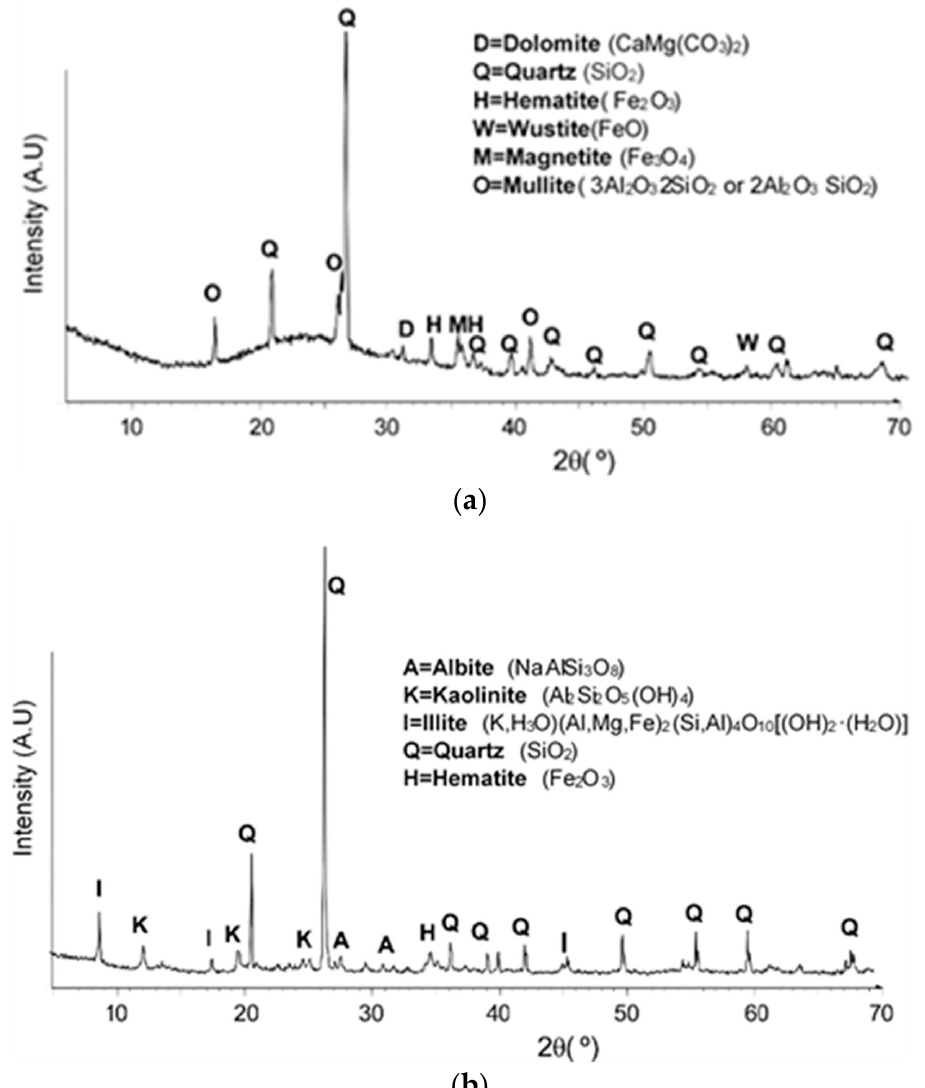
Figure 1. XRD pattern of FA ( a ) and clay ( b ).